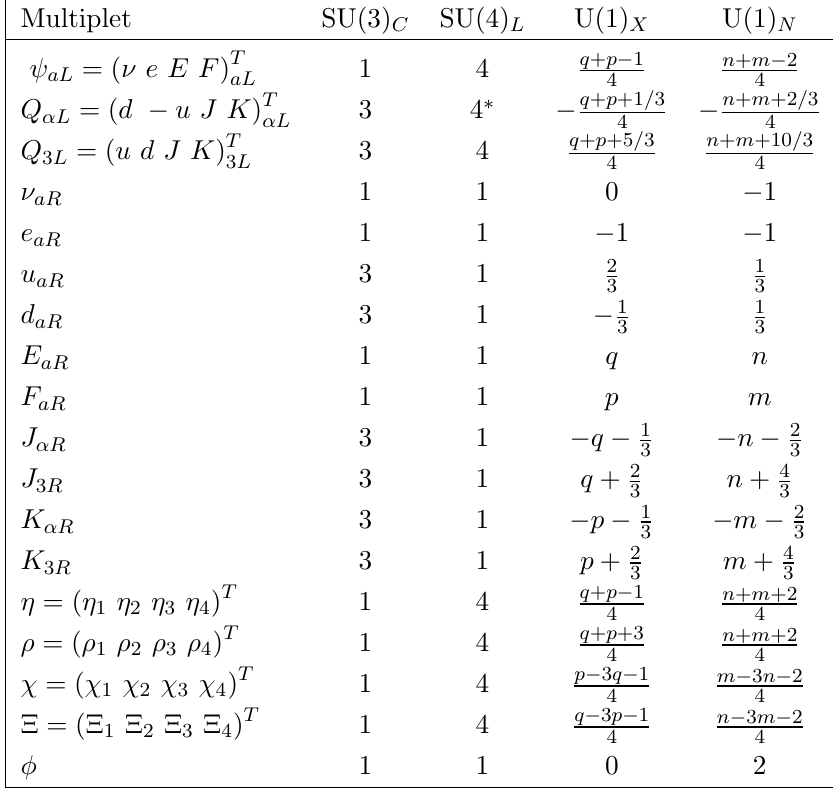
Table 2 . Field representation content of the